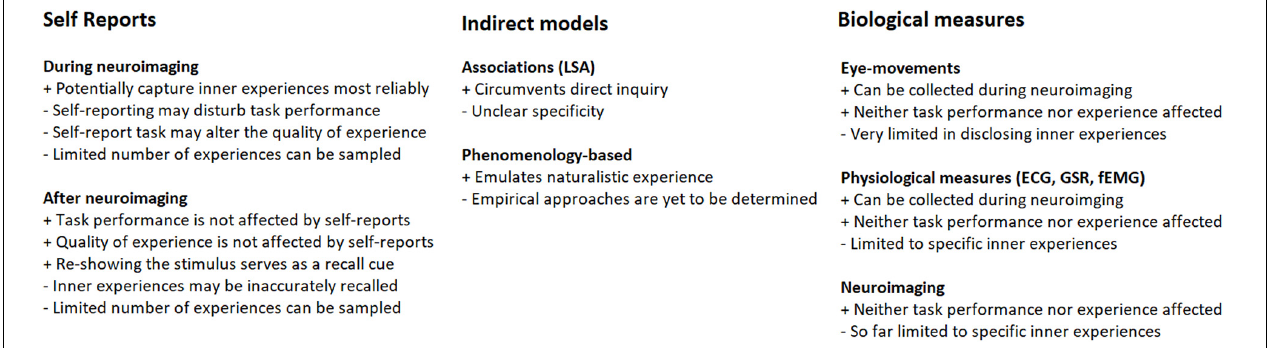
FIGURE 1 | Summary illustration of the different types of approaches that are available for sampling of inner experiences. The potential strengths and limitations are indicated with + and – signs.